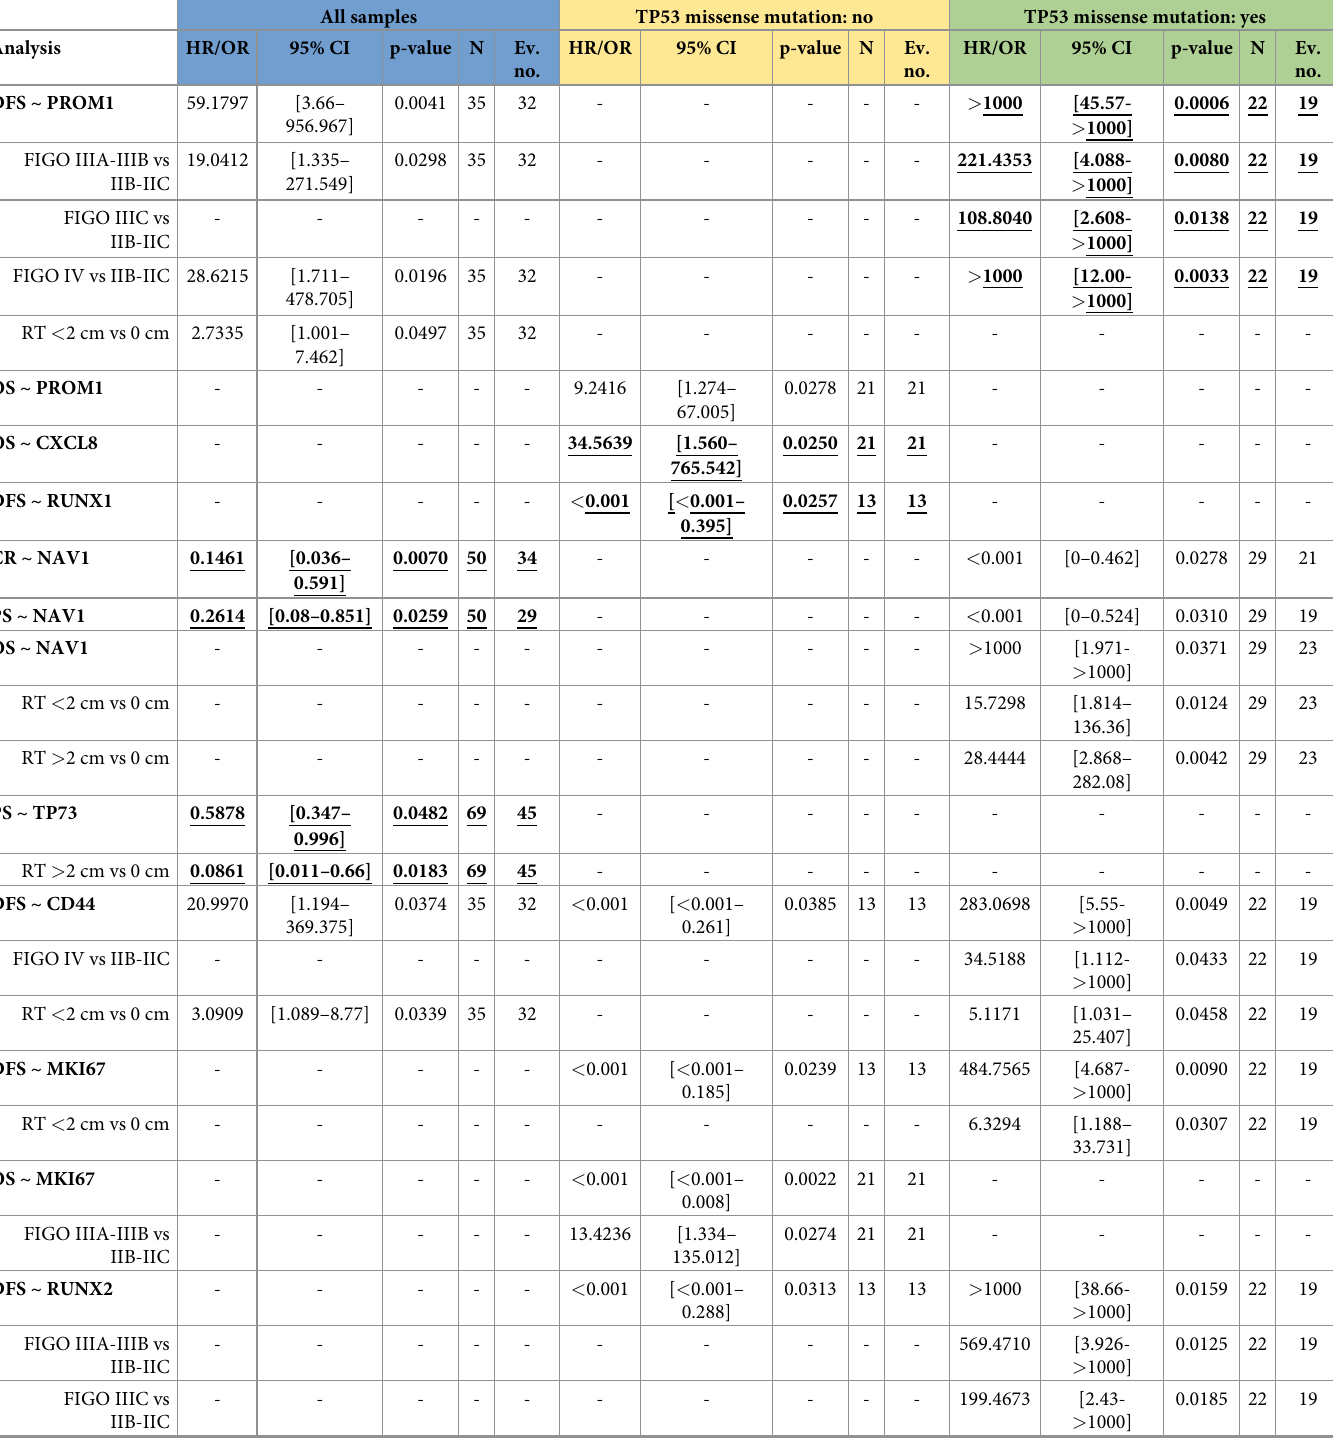
Table 1. The selected significant results of the multivariate Cox and logistic regression analyses obtained for the experimental cohort of HGSOCs. The results con- firmed in the validation cohort are emboldened and underlined. For all the significant results, refer to the S2 Table. All samples